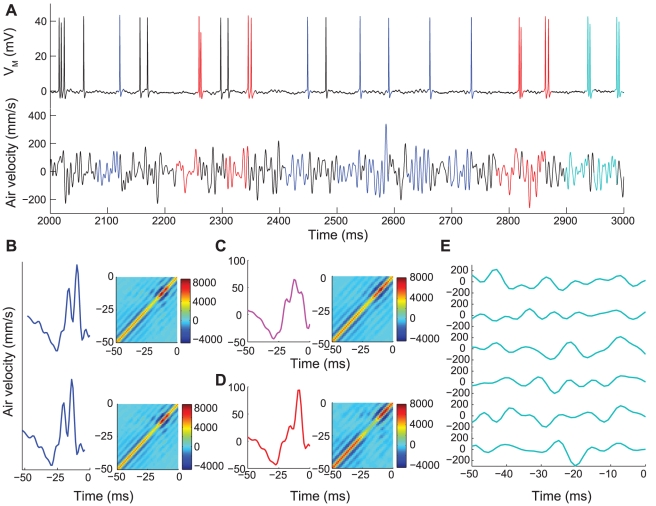
Schematic of modeling event-conditioned stimuli.A: Simultaneous recording of one second of GWN wind stimulus (bottom trace) and intracellular membrane potential (upper trace) from the same interneuron as in Figure 3. Well-isolated response patterns are divided into isolated single spike responses (blue) and ∼2 ms doublets (red and cyan). Response patterns which either are not sufficiently isolated are not considered in subsequent analysis (black). The 50 ms of the stimulus preceding the second spike of the response pattern is highlighted in matching colors (bottom trace). B, Upper panel: Gaussian model of 50 ms of stimulus preceding an isolated single-spike response, consisting of a mean (blue, left panel) and covariance (right panel, color scale in mm2/sec2) of the entire single-spike-conditioned stimulus ensemble (13,375 events from 30 minutes of recording). B, Lower panel: Same Gaussian model as in upper panel, offset by 2 ms. C: Synthetic Gaussian model of stimulus preceding 2 ms doublets, obtained by summing the means from panel B (cyan, left panel), and summing and then constraining the covariances (Eq. 6). D: Gaussian model (mean, red, and covariance) of 50 ms of stimulus preceding isolated doublet response patterns with 2 ms ISIs, based on 90% of the doublet-conditioned stimulus ensemble (2,652 events from 30 minutes of recording). E: Selection of 6 of the 294 stimulus samples which elicited a 2 ms doublet response and that were not used to build the Gaussian model in panel D, to later be used for likelihood testing.